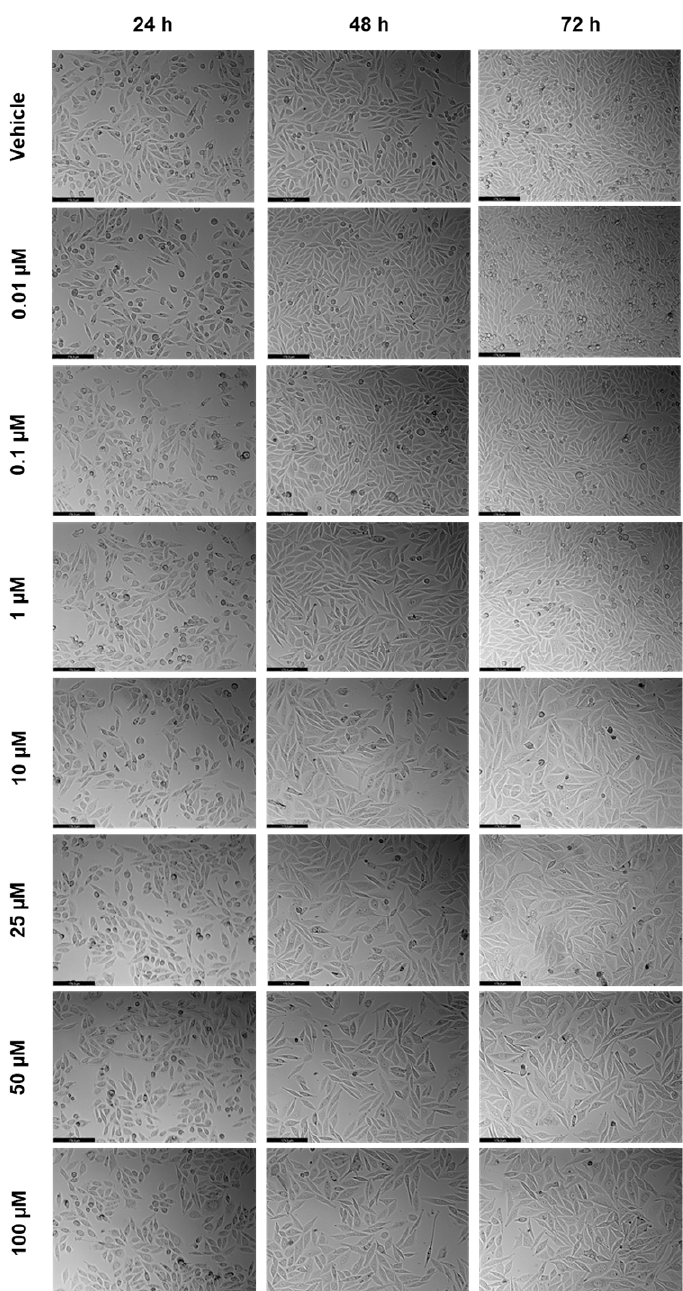
Figure 2. Morphological evaluation of PC-3 after exposure to increasing concentrations of 5-FU (0.01–100 µ M) for 24, 48, and 72 h. Control cells were treated with the vehicle (0.01% DMSO). These images are representative of three independent experiments for 24 h, and six independent experiments for 48 h and 72 h. The scale bar is 200 µ